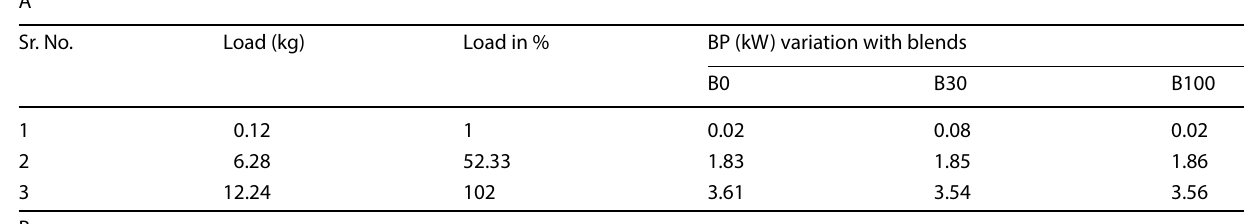
Table 4 A Break power for each load at varying blends. B Break power for each load at varying nanoparticles proportion A Sr. No.